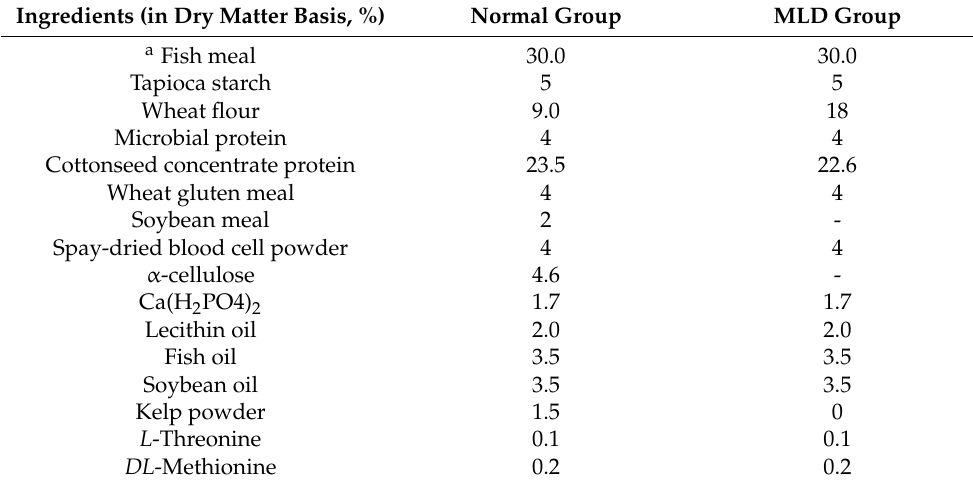
Table 1. Formulation and composition of experimental diets